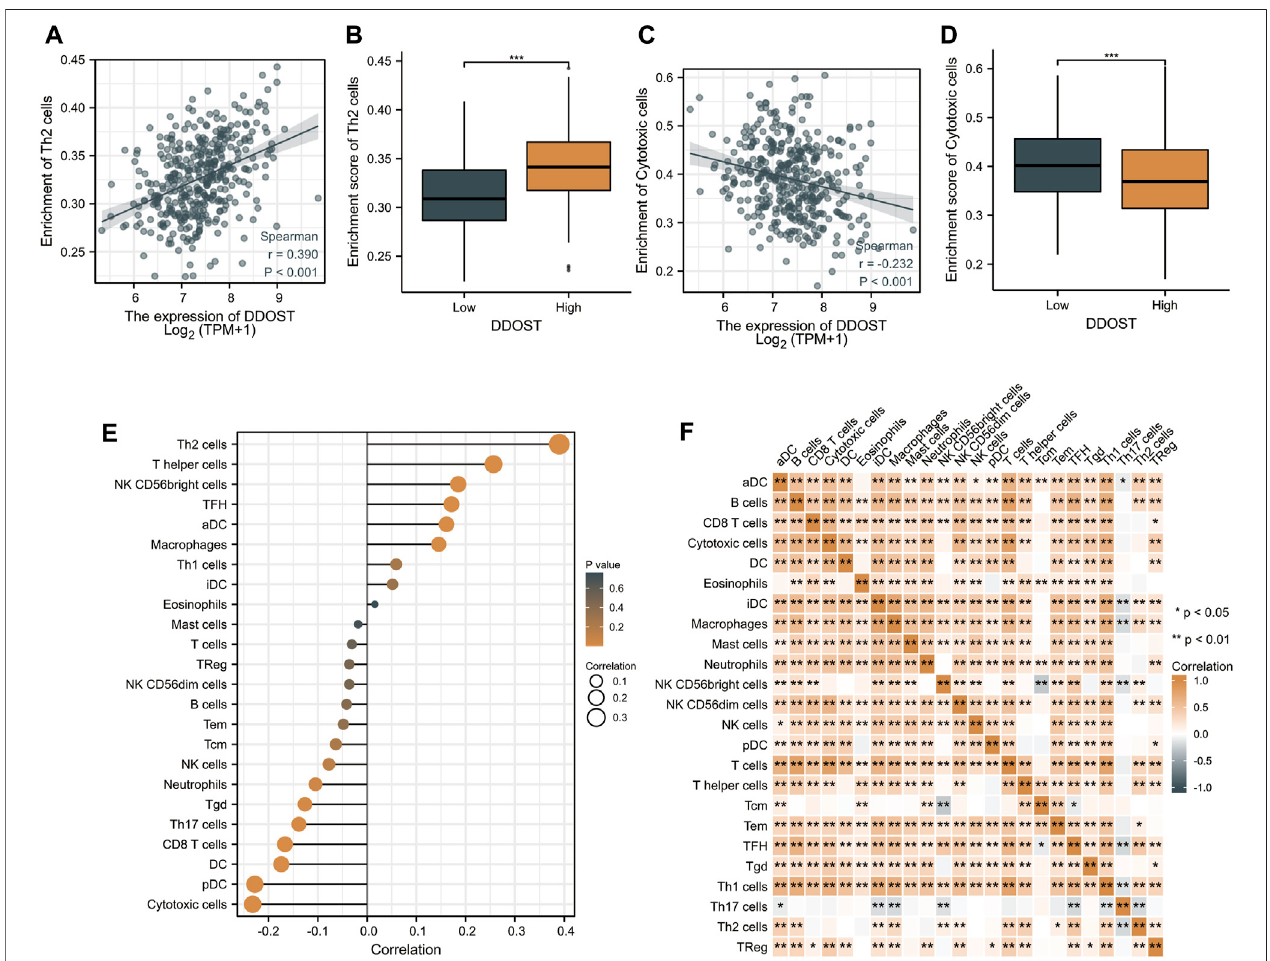
FIGURE3| The resultsofanalysisbetweenDDOST expression and immune in fi ltration. (A) Thepositive correlation betweenDDOST expression and Th2cells. (B) Th2 cells ’ in fi ltration level in different DDOST expression groups. (C) The negative correlation between DDOST expression and cytotoxic cells. (D) Cytotoxic cells ’ in fi ltrationlevelindifferentDDOSTexpression groups. (E) CorrelationbetweenDDOSTexpressionlevelandtherelativeabundancesof24immunecells. (F) Heatmapof 24 immune in fi ltration cells in HCC.